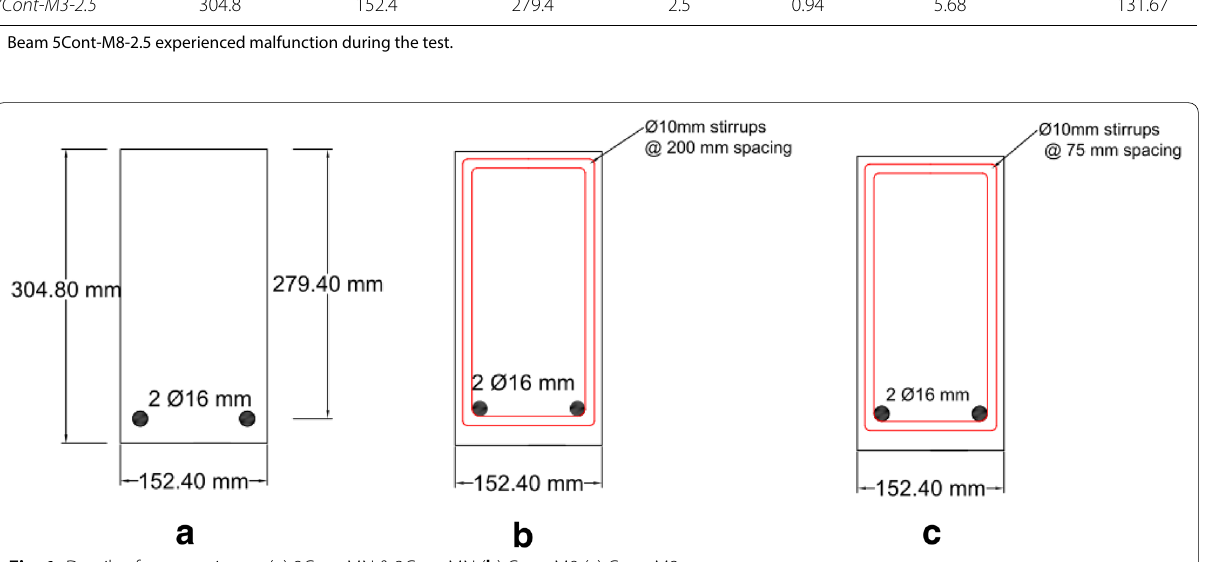
Fig. 1 Details of test specimens ( a ) 2Cont MN & 3Cont MN ( b ) Cont. M8 ( c ) Cont. M3.